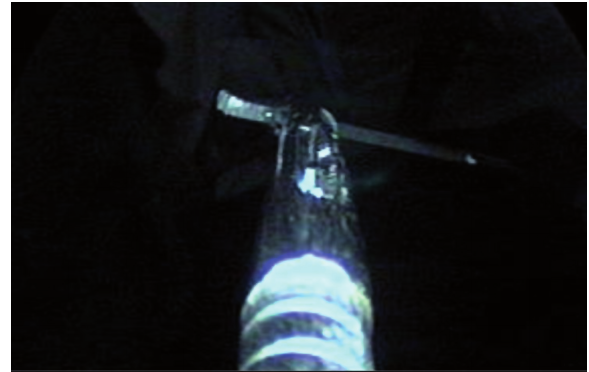
Figure 3 - Removal of knife